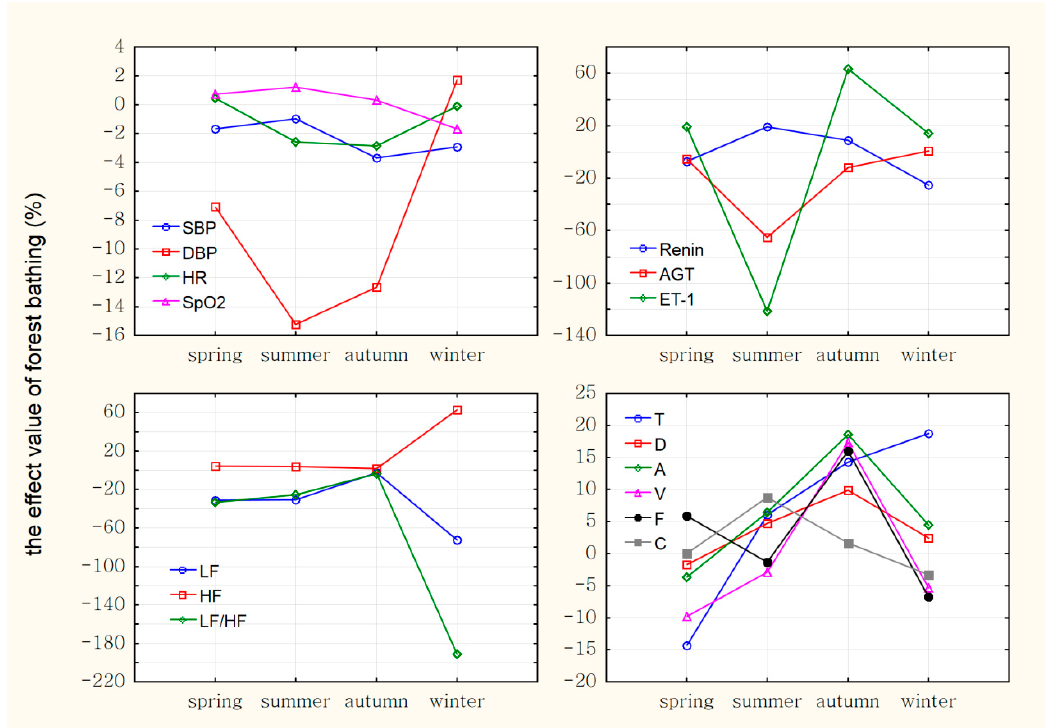
Figure 3. The effect of forest bathing across four